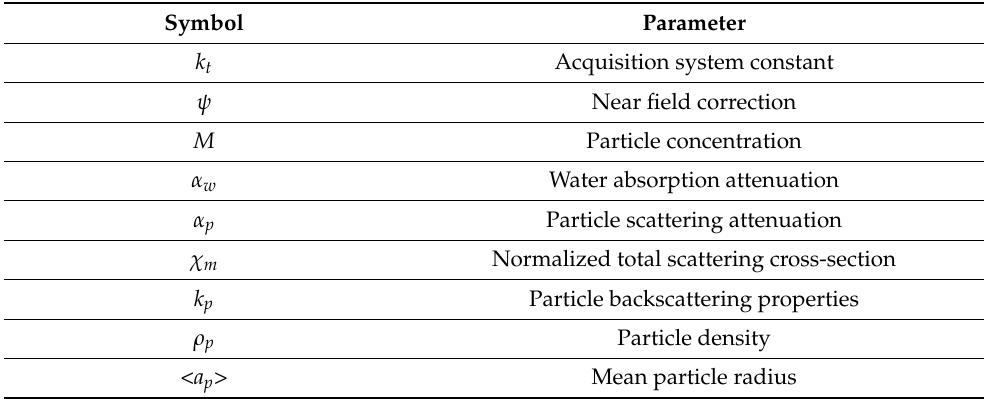
Table 1. Parameter